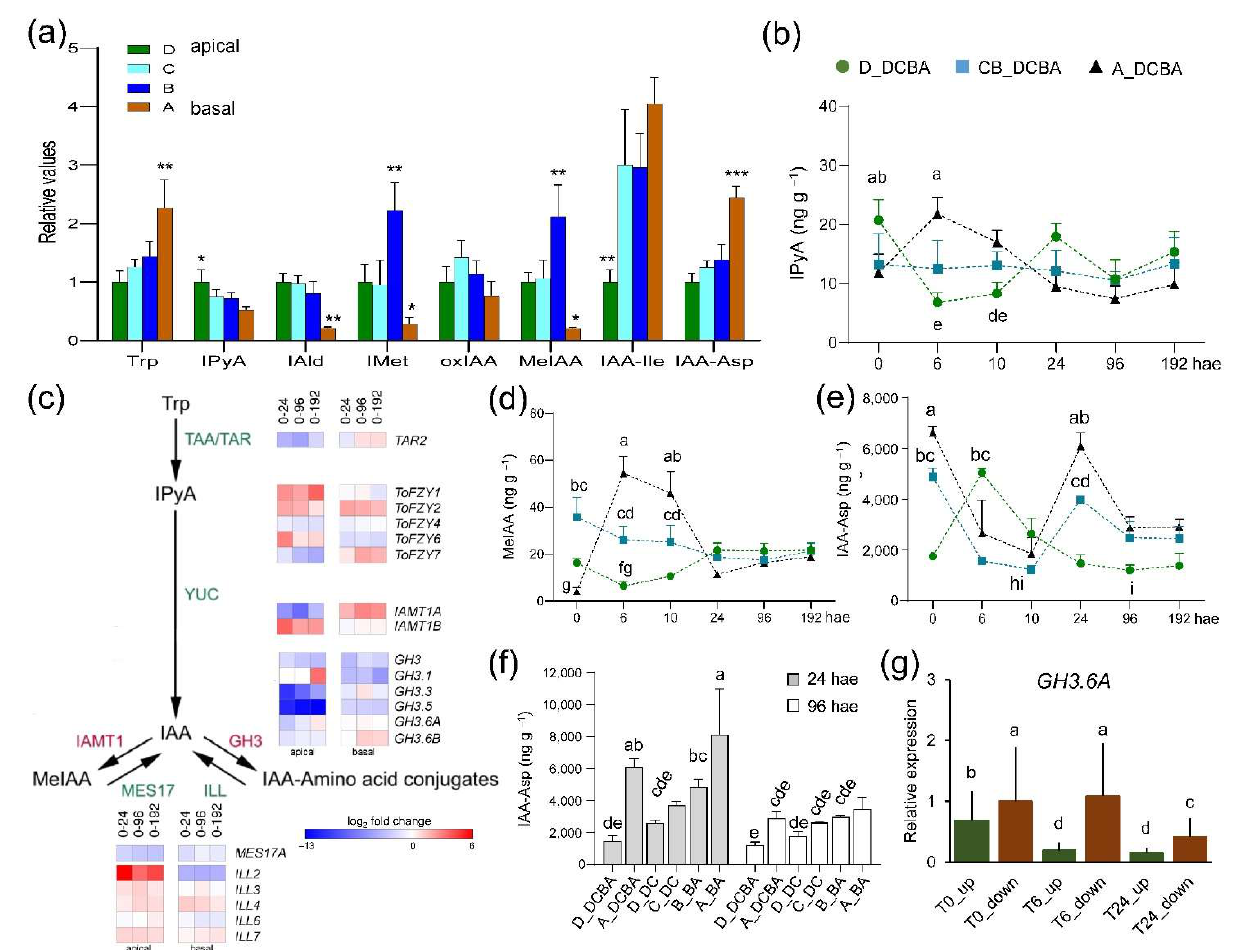
Figure 4. Accumulation of auxin metabolites during de novo organ formation. ( a ) Relative endogenous levels of several auxin precursors and derivatives at 0 hae as regards to those in the apical region of the hypocotyl explants; asterisks indicate significant differences ( p -value < 0.05 *, 0.01 **, or 0.001 ***) between the studied regions in whole hypocotyl explants (DCBA fragments). ( b ) Endogenous levels of indole-3-pyruvic acid (IPyA) during the studied time course. ( c ) DEGs involved in auxin biosynthesis and homeostasis. Expression values of DEGs (FDR < 0.01) were in log 2 fold change relative to 0 hae according to the scale bar in the figure. ( d , e ) Endogenous levels of methyl-IAA (MeIAA; d), and indole-3-acetyl-L-aspartate (IAA-Asp; e) during the studied time course. ( f ) Endogenous levels of IAA-Asp at 24 and 96 hae in apical (D) and basal (A) regions of whole (DCBA) or half-sectioned (DC and BA) hypocotyl explants. ( g ) Relative expression levels of GH3.6A at 0, 6 and 24 hae in apical (green bars) and basal (brown bars) regions of the whole hypocotyl explants. Different letters in b, d-g indicate significant differences ( p -value < 0.01) between samples.